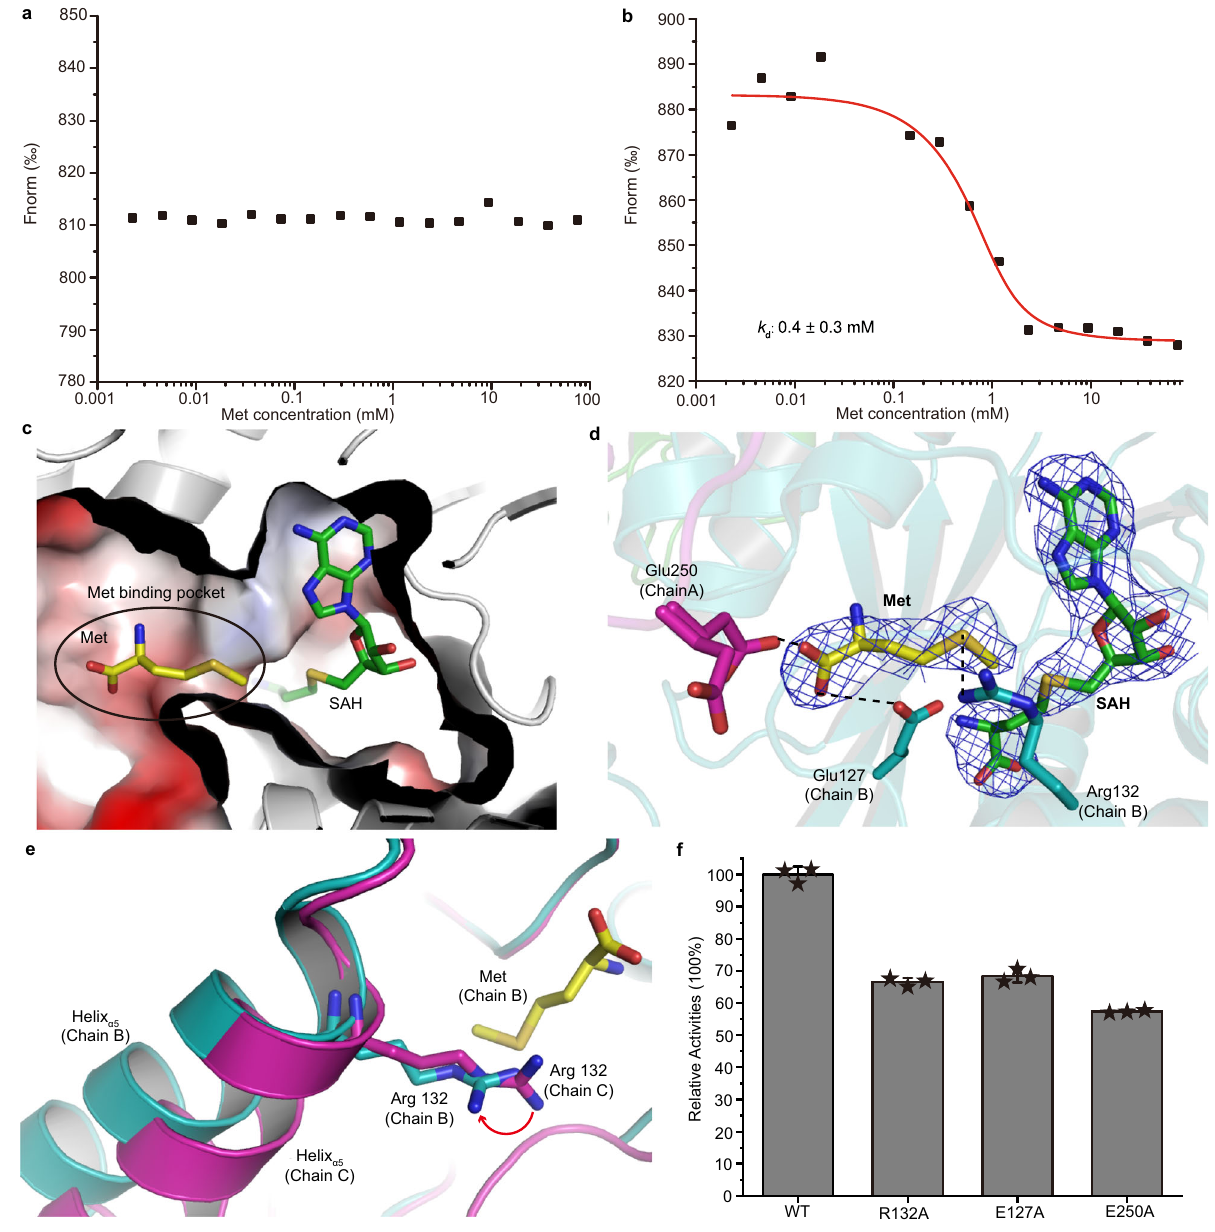
Fig. 5 Structural analyses of important residues and molecules in the MmtN Met-binding site. a MST analysis of Met binding to MmtN. The Met is titrated from 2.3 μ M to 75 mM. The signal/noise ratio is too low to conclude binding. The data shown are representatives of triplicate experiments. b MST analysis of Met binding to the MmtN-SAH complex. The Met is titrated from 2.3 μ M to 75 mM. The change in the thermophoretic signal leads to a K d of 0.4 ± 0.3 mM. The data shown are representatives of triplicate experiments. c Electrostatic surface of the MmtN-SAH-Met ternary complex crystal structure. SAH and Met are shown as green and yellow sticks, respectively. The Met-binding pocket is marked as a black circle. d Locations of SAH and Met in the active center of MmtN. The SAH and Met molecules are shown as magenta and yellow sticks, respectively. The 2 F o -F c densities for SAH and Met are contoured in blue at 1.0 σ . e The gating function of Helix α 5 for Met entry. Chain B of MmtN-SAH-Met complex is colored in cyan, and chain C in magenta. Met is shown as yellow sticks. The moving direction of Arg132 is shown in red arrow. f Enzymatic activities of MmtN variants. The enzymatic activity of MmtN was taken as 100%. Data are presented as mean ± standard deviations (SD) ( n = 3 independent experiments, indicated by stars on the bar chart). Source data are provided as a Source Data fi